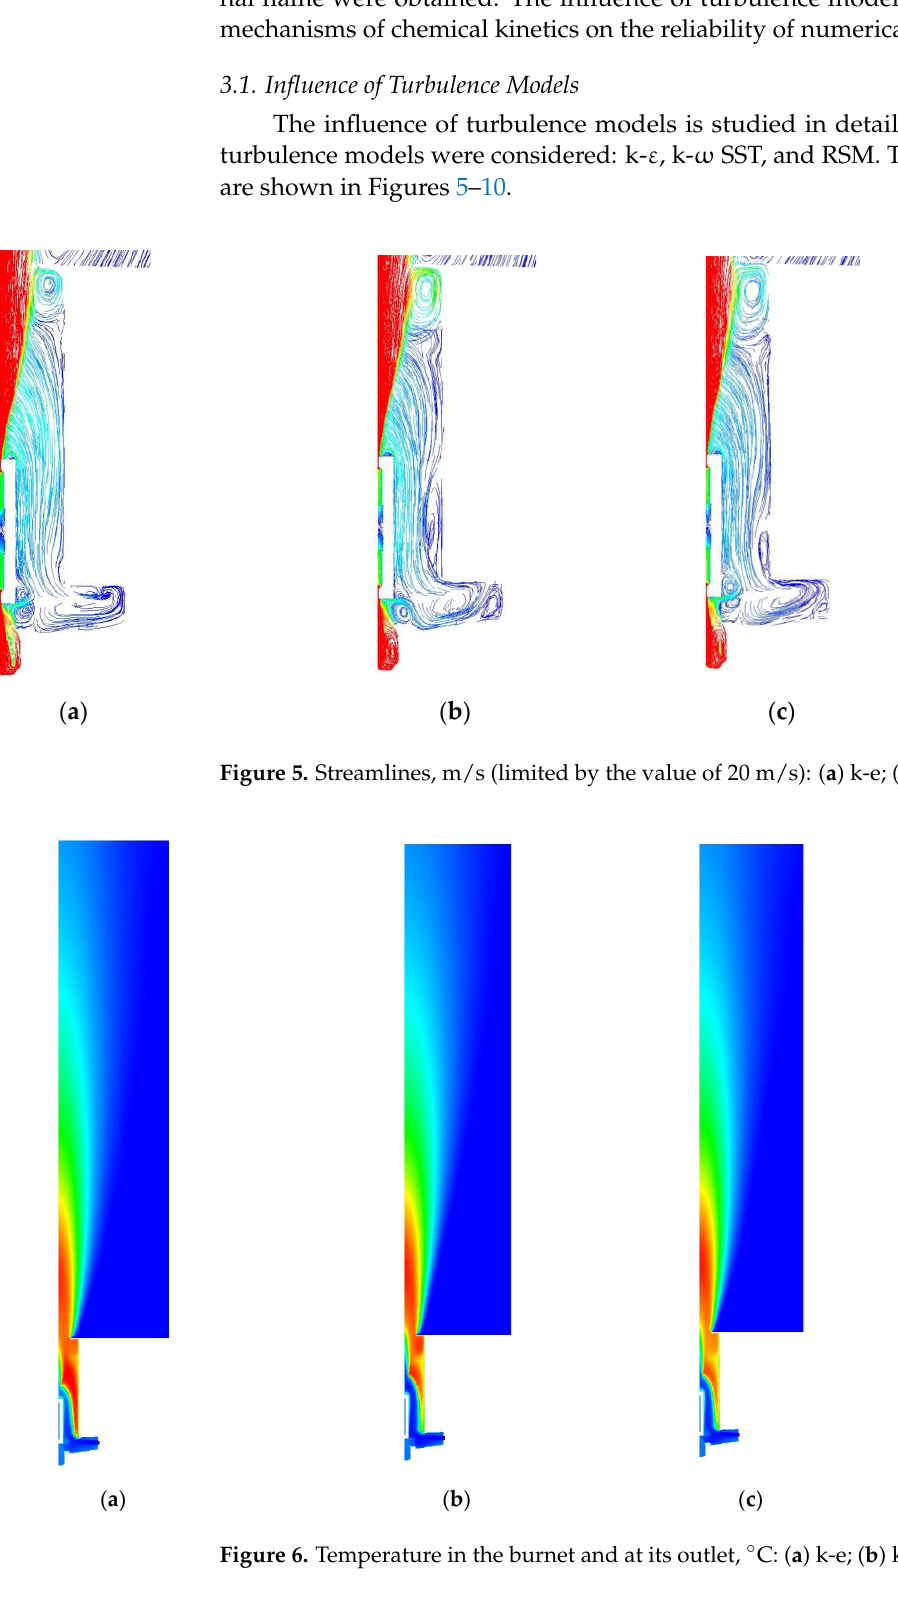
( c ) Figure 7. Volume fraction of O 2 : ( a ) k-e; ( b ) k-w SST; ( c ) RSM.